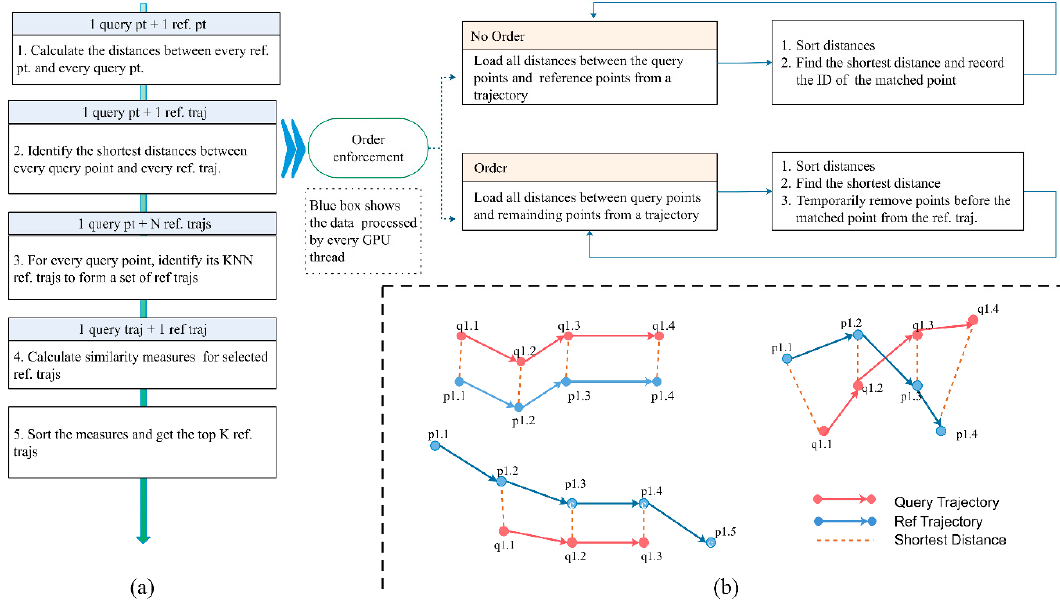
Figure 1. The workflow of K-BCT query: ( a ) major steps; ( b ) examples of identifying the matched points.